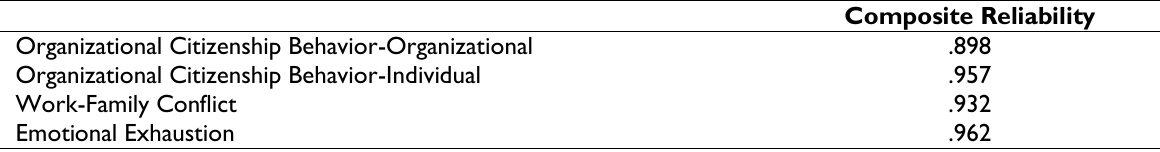
Table 2. Reliability